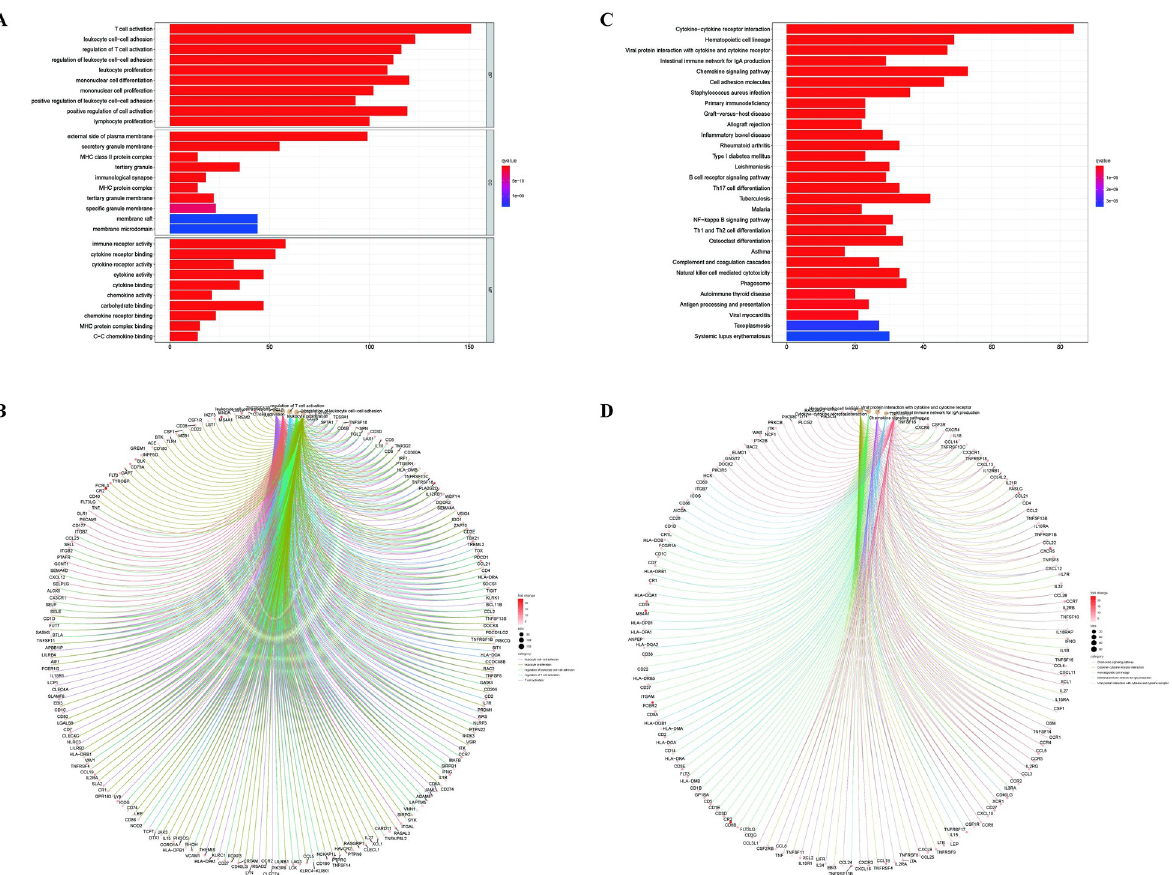
Fig 4. Functional enrichment analysis of DEGs. (A, B) The results of the GO annotation analysis of the DEGs. (C, D) The results of the KEGG pathways enrichment analysis of